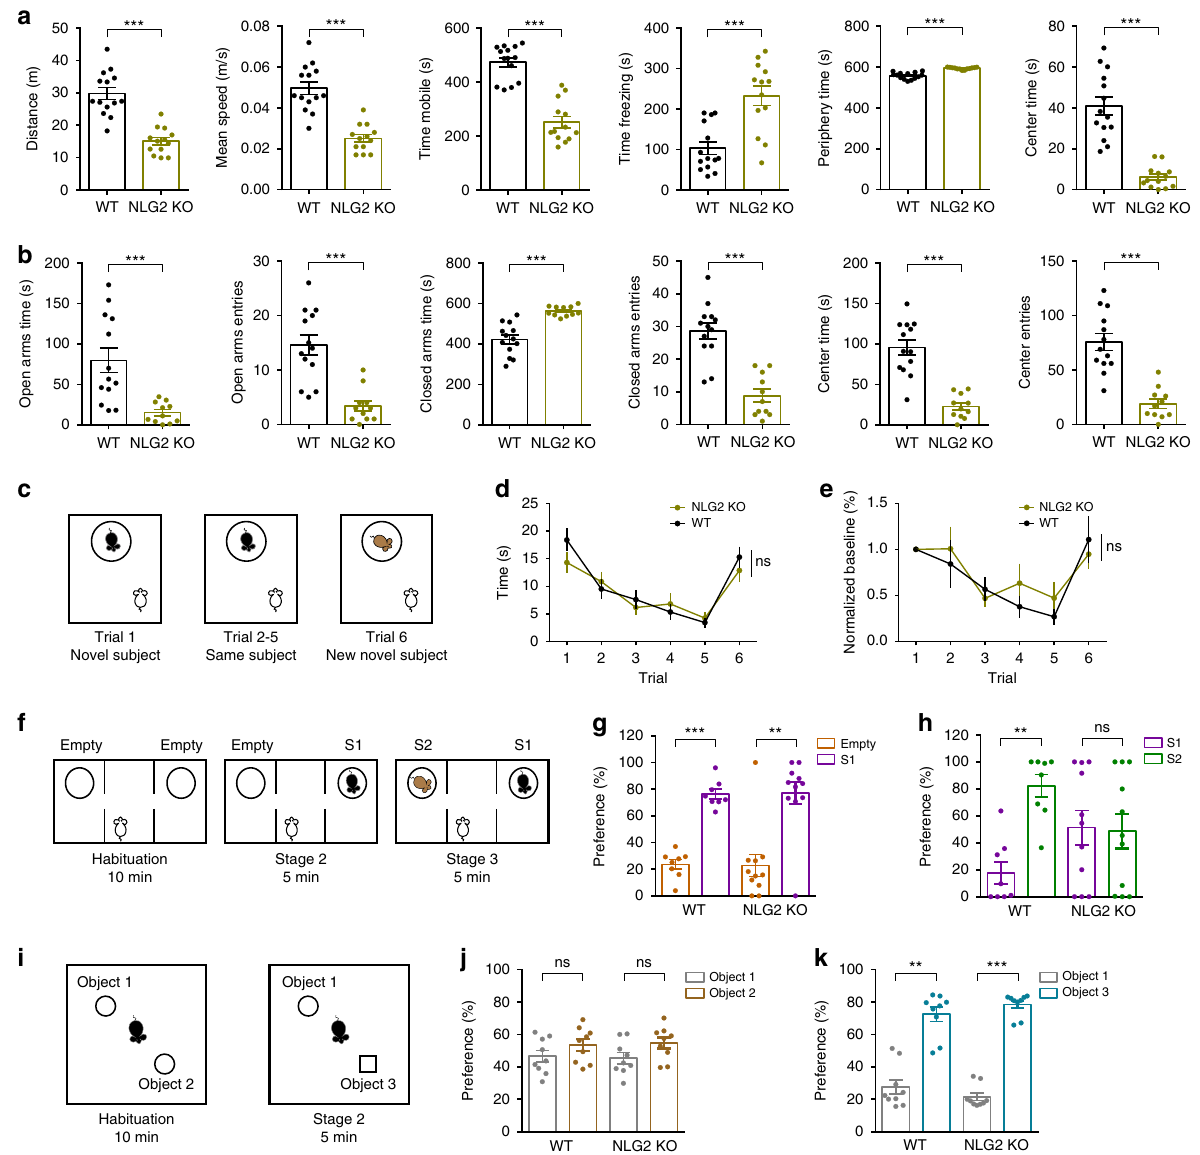
Fig. 4 Reduced locomotion, increased anxiety, and impaired social memory in NLG2 KO mice. a Open fi eld test showing decreased travel distance ( p < 0.0001), travel speed ( p < 0.0001), and mobile time ( p < 0.0001), increased freezing time ( p < 0.0001), increased time spent in periphery zone ( p < 0.0001), and decreased time spent in center zone ( p < 0.0001) in NLG2 KO ( n = 13) compared with WT mice ( n = 14). b Elevated plus maze test showing decreased time spent in open arms ( p = 0.0009), decreased open arms entries ( p < 0.0001), increased time spent in closed arms ( p < 0.0001), decreased closed arm entries ( p < 0.0001), decreased time spent in center ( p < 0.0001), and decreased center entries ( p < 0.0001) in NLG2 KO ( n = 11) compared with WT mice ( n = 13). c Schematic diagram of the fi ve-trial habituation/dishabituation assay. d Summary data of the fi ve-trial assay showing similar memory acquisition during trials 1 – 5 and preference for a novel mouse in trial 6 (two-way ANOVA, p = 0.4640) in WT ( n = 18) and NLG2 KO mice ( n = 18). e Normalized interaction time of ( d ) showing no differences (two-way ANOVA, p = 0.5322) between WT ( n = 18) and NLG2 KO ( n = 18) mice. f Schematic diagram of the three-chamber social interaction test. g Normalized interaction time showing similar preference for S1 over empty cage during stage 2 of the three-chamber social test in WT ( n = 8) and NLG2 KO mice ( n = 11) (WT: p = 0.0002, NLG2 KO: p = 0.0083). h Impaired preference for S2 over S1 during stage 3 of the three-chamber social interaction test in NLG2 KO ( n = 11) compared to WT mice ( n = 8) (WT: p = 0.0061, NLG2 KO: p = 0.9237). i Schematic diagram of the novel object recognition test. j Novel object recognition test showing similar preference for object 1 and object 2 in WT ( n = 9) and NLG2 KO mice ( n = 9) (WT: p = 0.3748, NLG2 KO: p = 0.2149). k Increased preference for object 3 over object 1 during stage 2 in both WT ( n = 9) and NLG2 KO mice ( n = 9) (WT: p = 0.001, NLG2 KO: p < 0.0001). Data in a , b , d , e , g , h , j , and k represent mean ± SEM. Two-sided t -test was used for data in a , b , g , h , j , and k . * p < 0.05, ** p < 0.01, *** p < 0.001. ns nonsigni fi cant. Source data are provided as a Source Data fi